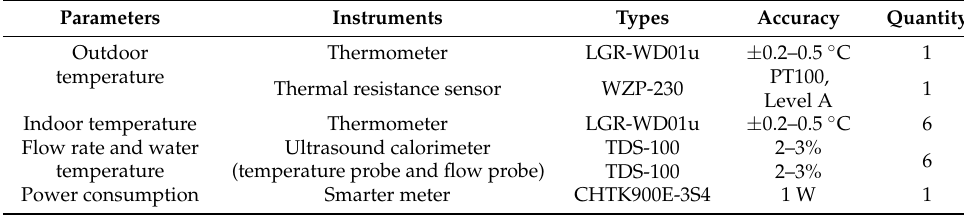
Table 3. Test parameters and instruments.